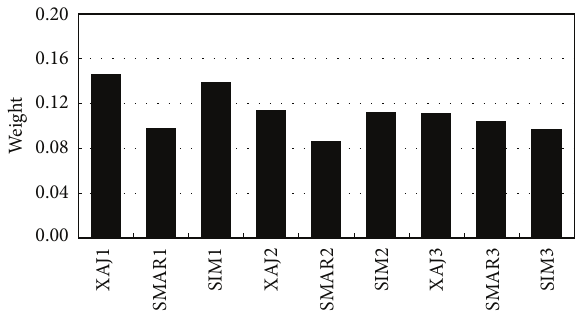
Figure 5: Histogram of weights of the individual model predictions in BMA(9)